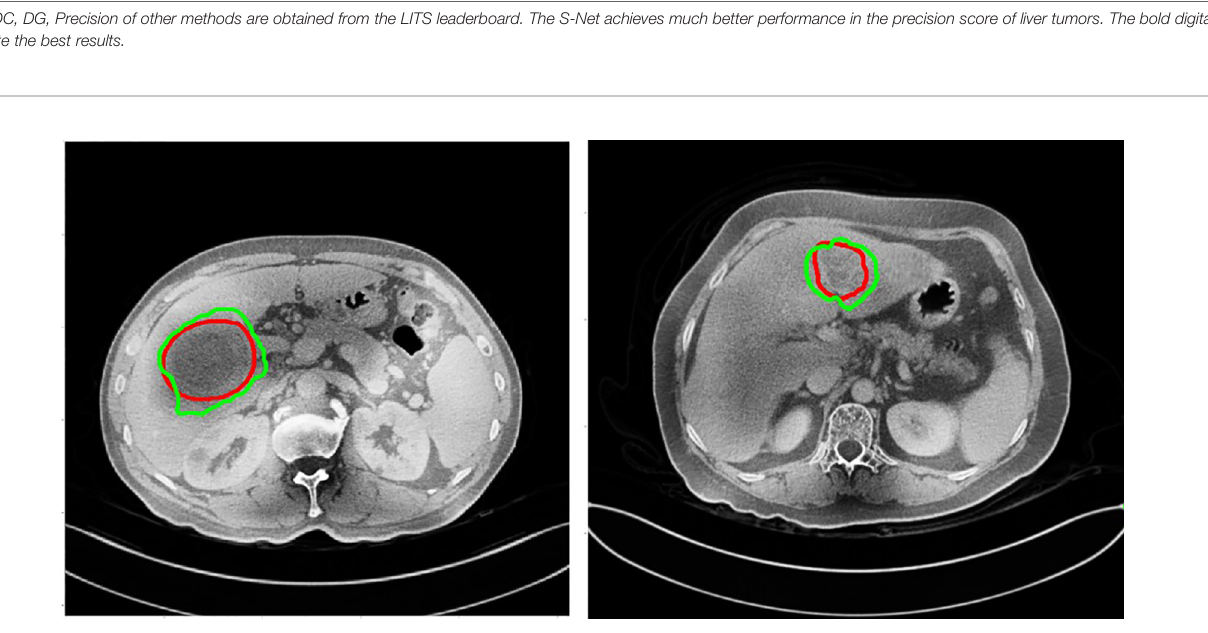
FIGURE 11 | The auto-delineation results of this study used by Hubei Cancer Hospital dataset. Green contour shows automatic results, while red shows the gold